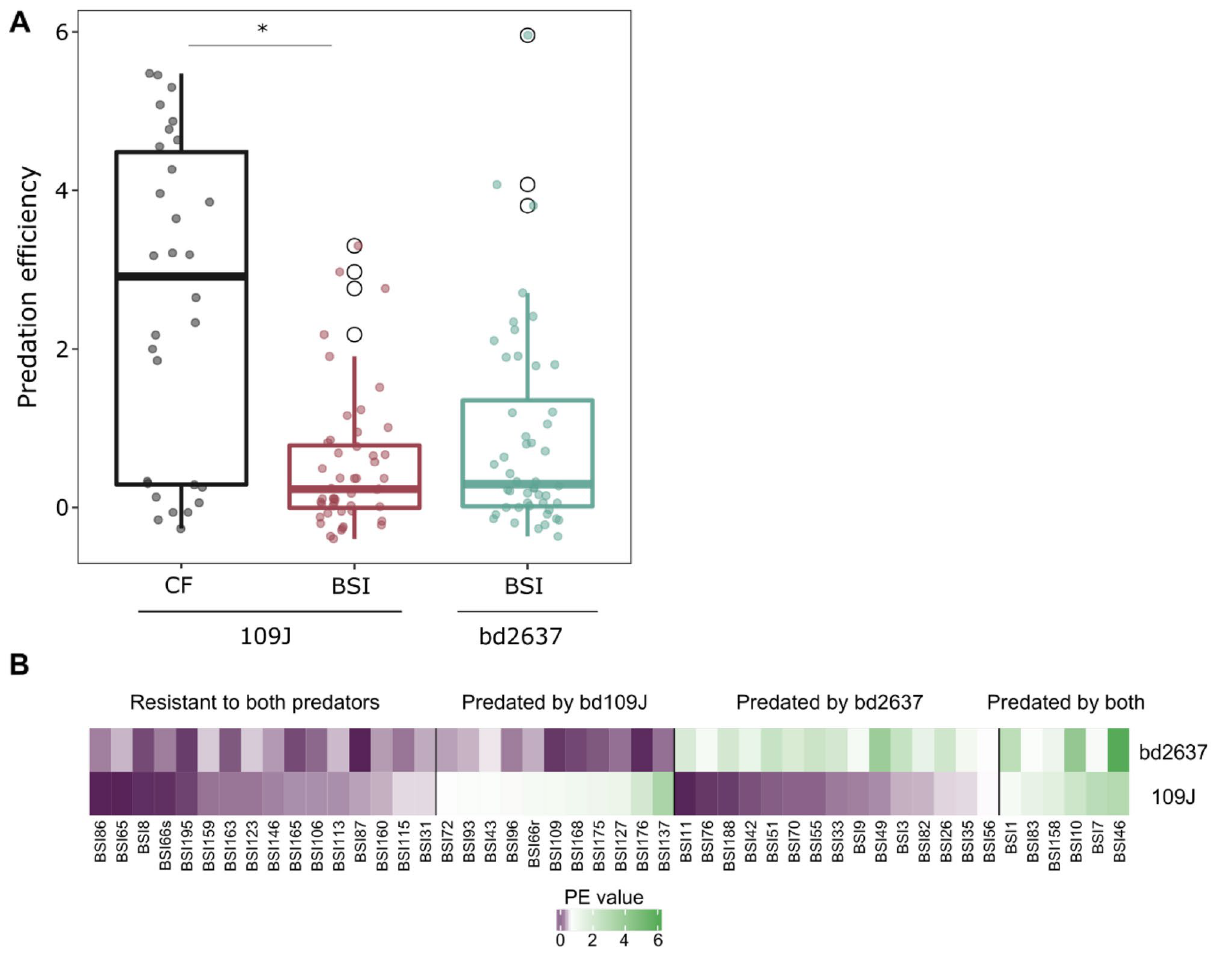
Figure 1. Predation susceptibility of P. aeruginosa collections. ( A ) Predation efficiency (PE) of B. bacteriovorus 109J on CF and BSI collection (*represents significance p < 0.0001) and PE of mutant strain bd2637 upon BSI collection ( p > 0.05). ( B ) PE profile of the wildtype B. bacteriovorus 109J and mutant strain bd2637 upon BSI collection. Positive predation was considered when PE > 0.5. Each strain has a specific predation profile. White circles in BSI collection represent